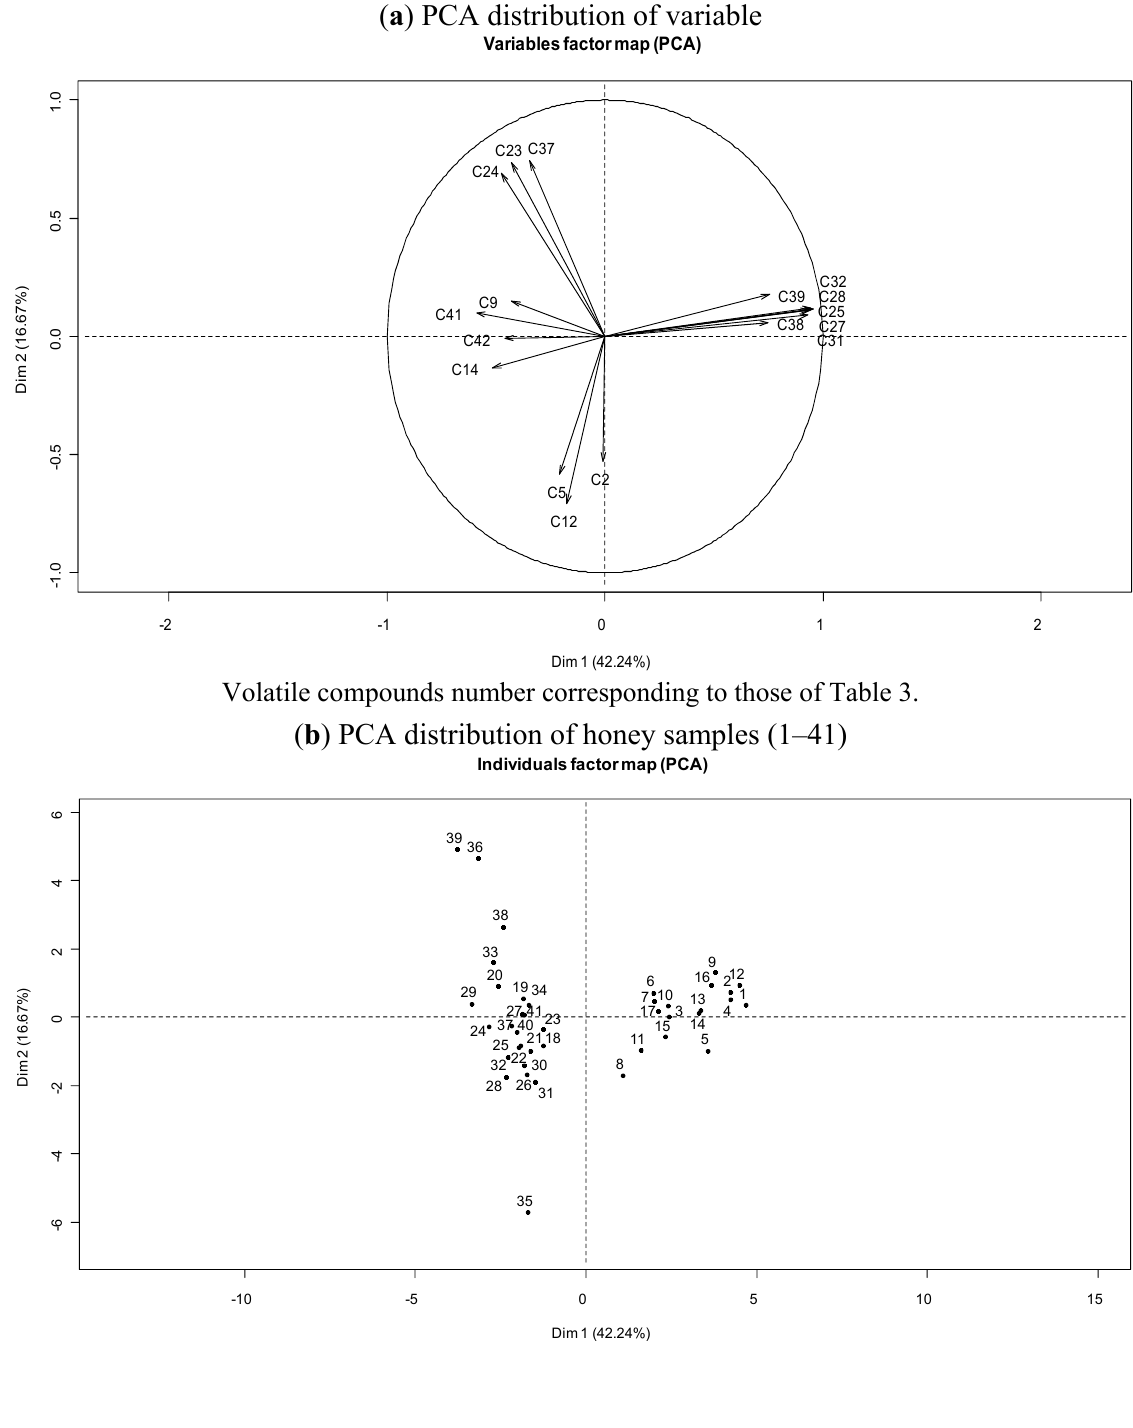
Figure 1. Principal component analysis (PCA) of Corsican “spring” honey volatile